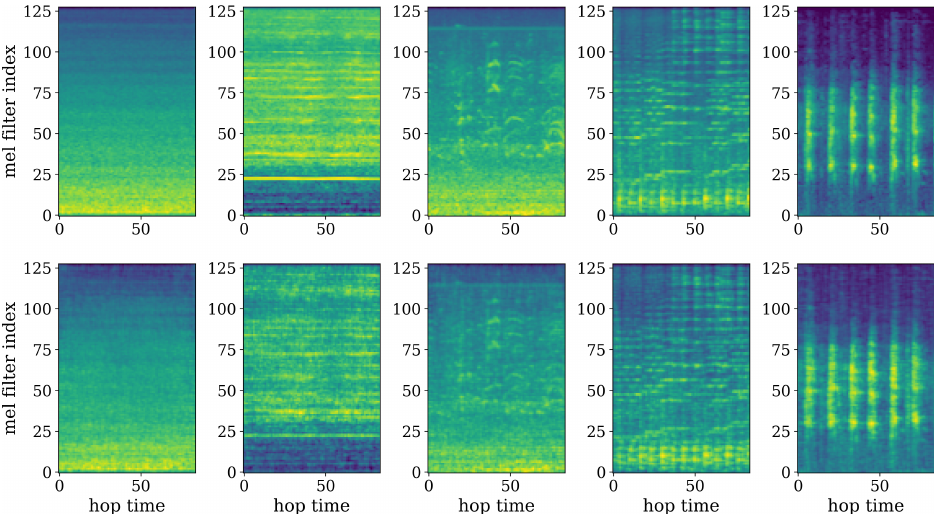
Figure 4. Qualitative assessment of the autoencoder. Random instances from the validation set of the UrbanSound8K dataset in the top row ( X i ) and their respective reconstructions in the bottom r X i row (